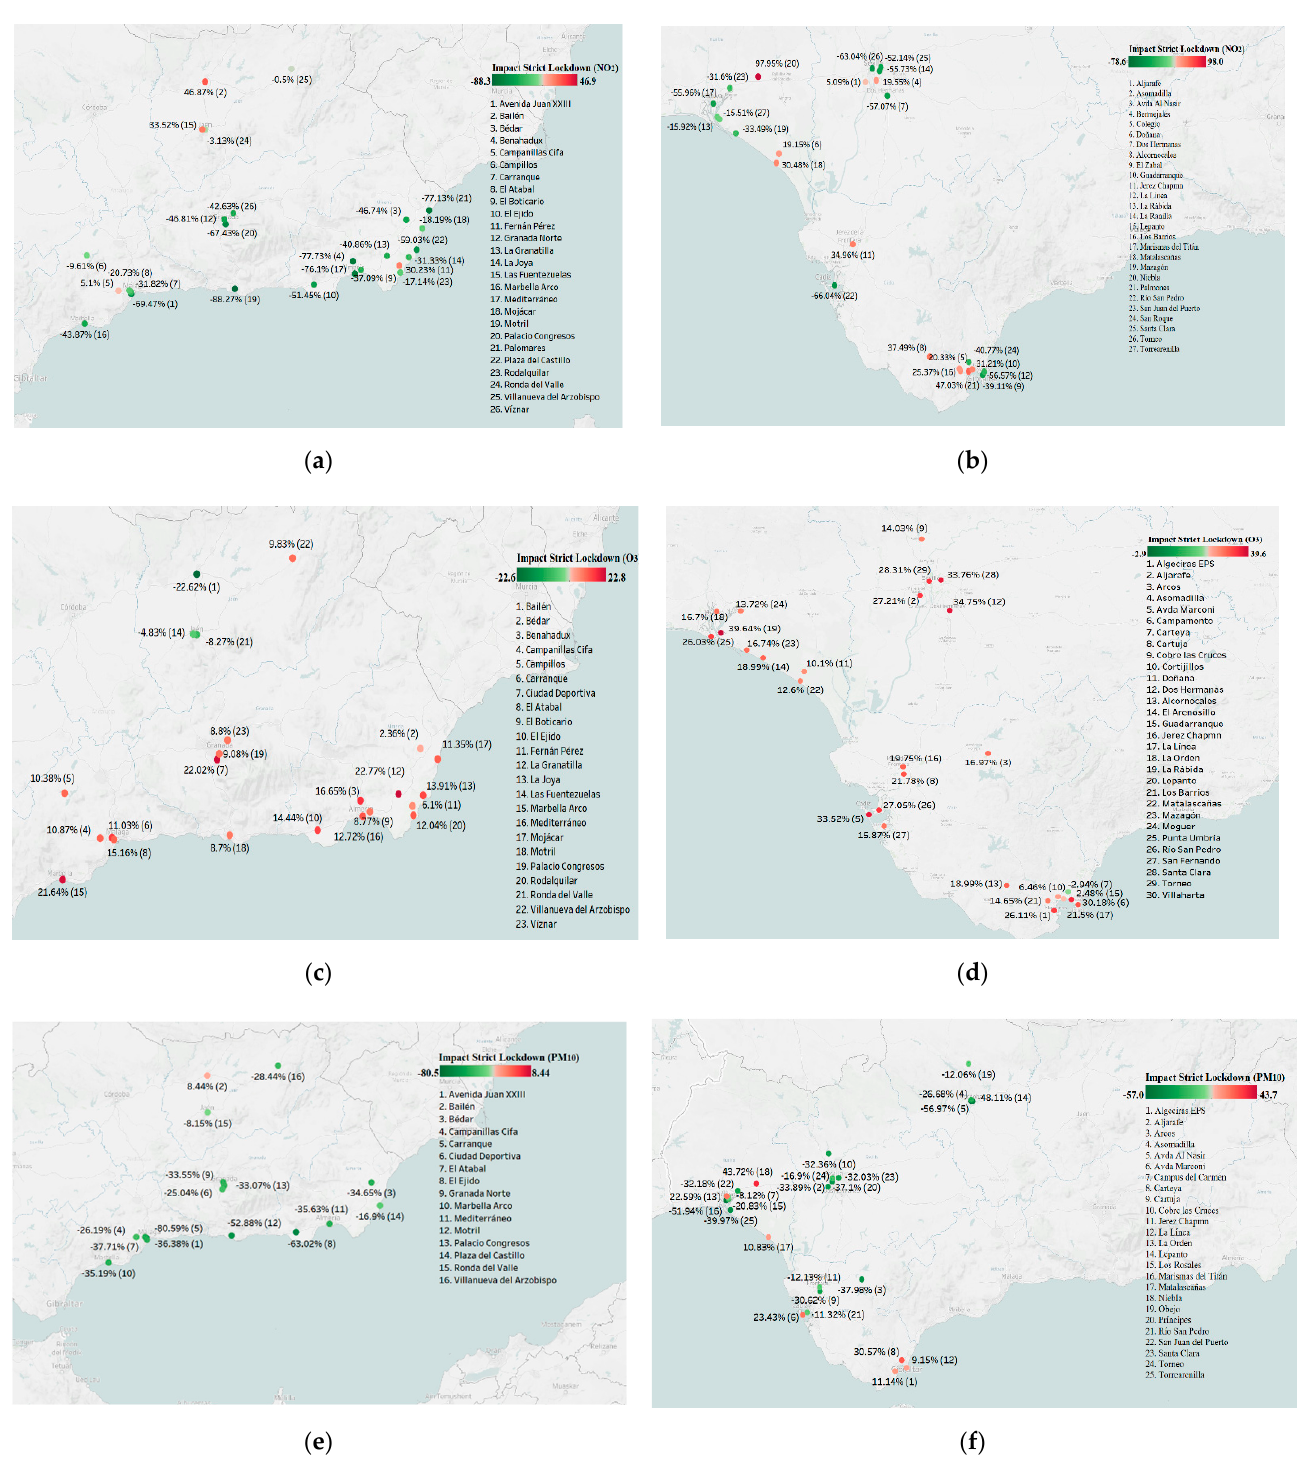
Figure 3. The left and right sides contain the Lockdown effect estimates by air monitoring stations in the SE and SW, respectively. ( a ) Strict lockdown (phase 0) impact on NO 2 in SE Andalusia ; ( b ) Strict lockdown (phase 0) impact on NO 2 in SW Andalusia; ( c ) Strict lockdown (phase 0) impact on O 3 in SE Andalusia; ( d ) Strict lockdown (phase 0) impact on O 3 in SW Andalusia; ( e ) Strict lockdown (phase 0) impact on PM 10 in SE Andalusia; ( f ) Strict lockdown (phase 0) impact on PM 10 in SW Andalusia.